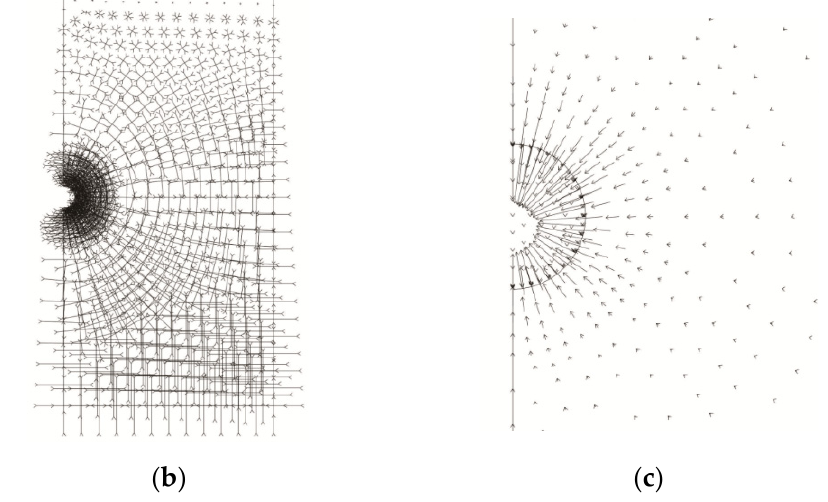
Figure 7. Distribution diagram of initial isotropic stress/displacement ( K o = 1.0) around the tunnel in finite element analysis ( a ) initial stress before excavation, ( b ) final stress state after excavation, and ( c ) total displacement after excavation.